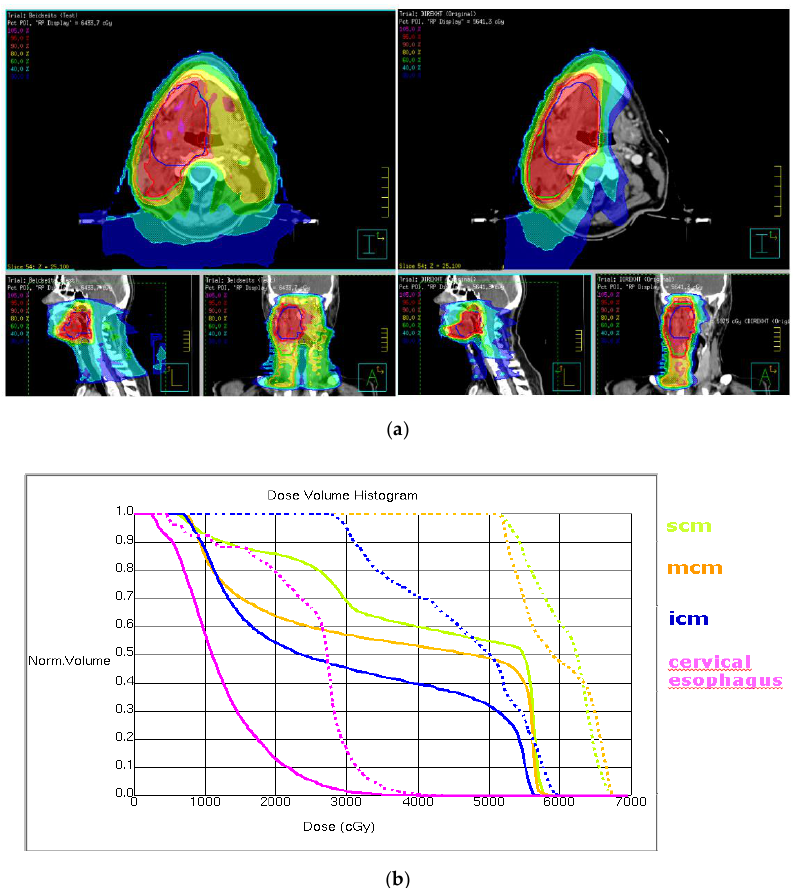
Figure 3. Male patient with a HPV-associated tonsillar carcinoma on the right side; TNM according to 7th edition of TNM classification: pT1pN2b (3 / 29 without ECS) L0 V0 Pn0 R0 cM0. According to study protocol this patient was treated with a reduced radiotherapy dose of 56 Gy in the primary tumor region only with ipsilateral elective neck irradiation. In the standard treatment plan, the patient would have received a total dose of 64 Gy in the primary tumor region and bilateral elective neck irradiation. ( a ) Dose distribution of the standard and study treatment plan (blue contour within the high-dose-volume is the boost which is additionally applied in the standard but not in the study treatment plan) with the study treatment plan showing especially significant reduced dose in contralateral neck and pharyngeal structures. In the study treatment plan most parts of the swallowing structures receive less than 30% of the prescribed dose while in the standard treatment plan large parts of the swallowing apparatus receive 40 to 60% of prescribed dose. ( b ) Dose-volume histogram of superior (light green), medial (orange), inferior (blue) constrictor muscle and cervical esophagus (pink) shows significantly smaller doses in constrictor muscles and cervical esophagus in the study (solid line) compared to the standard (dotted line) treatment